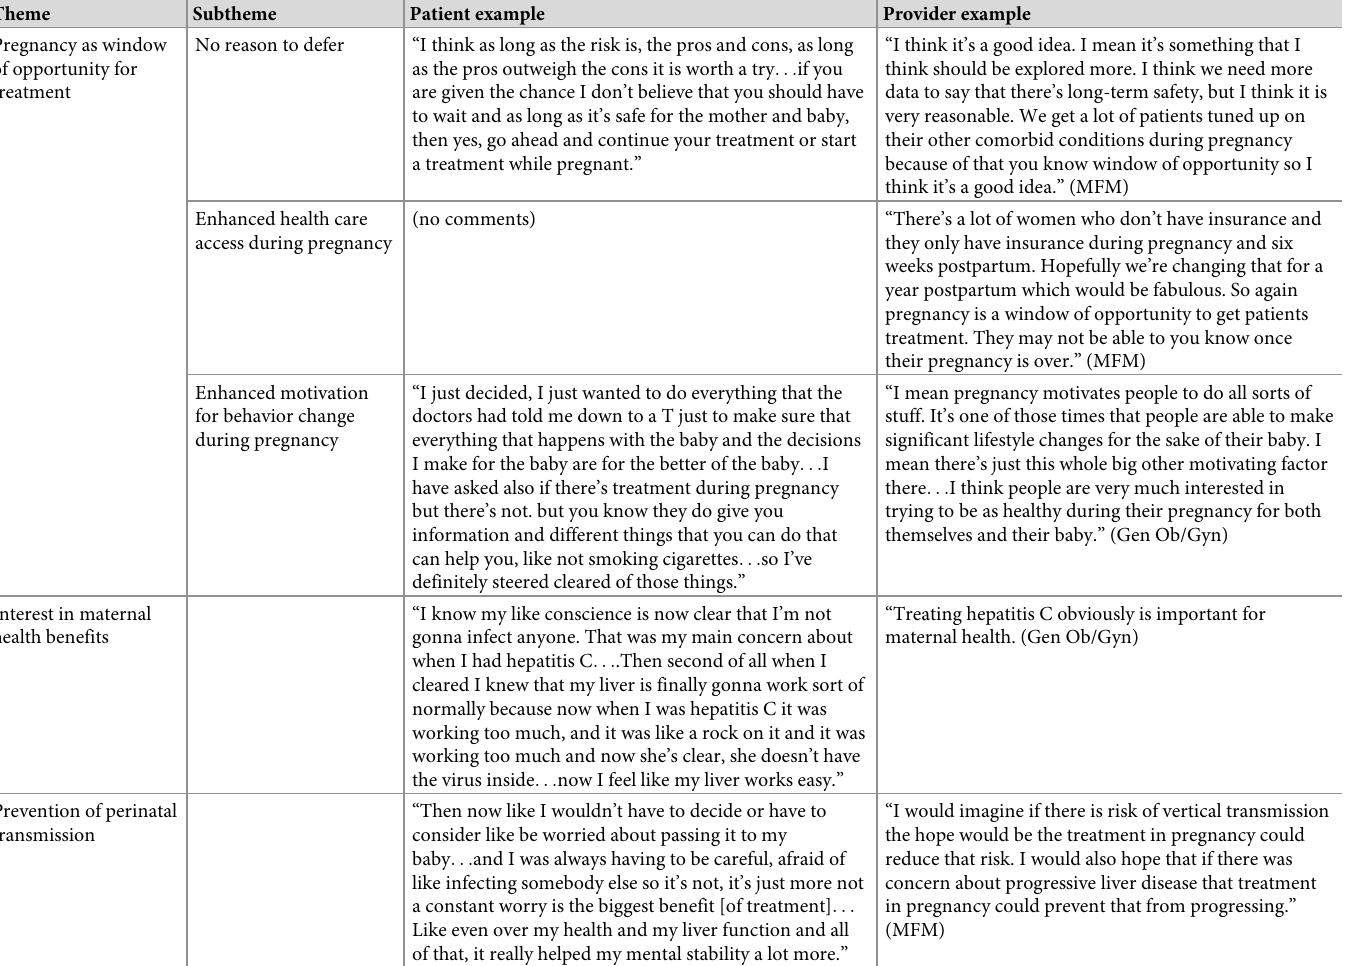
Table 4. Patient and obstetrician-perceived facilitators of treatment of HCV during